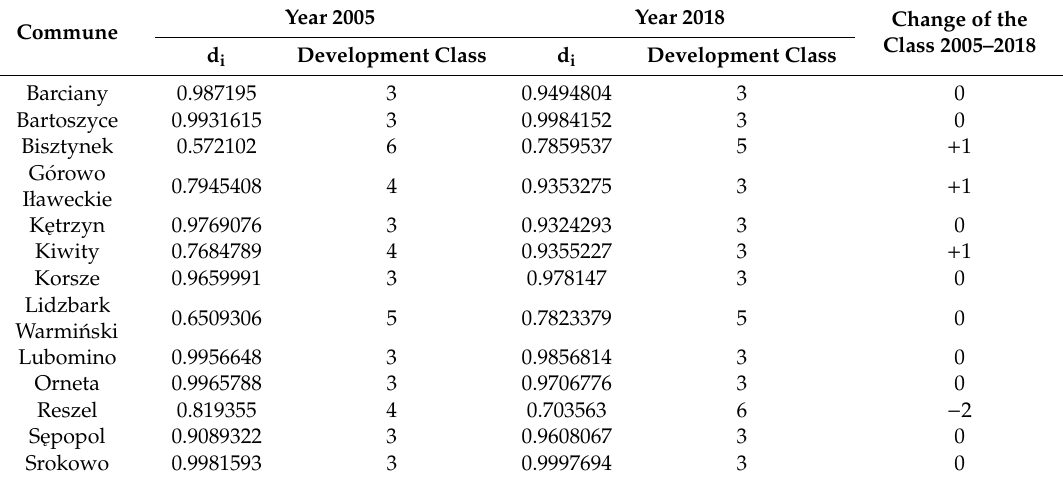
Table 3. Determining the level of social development for the analyzed communes.